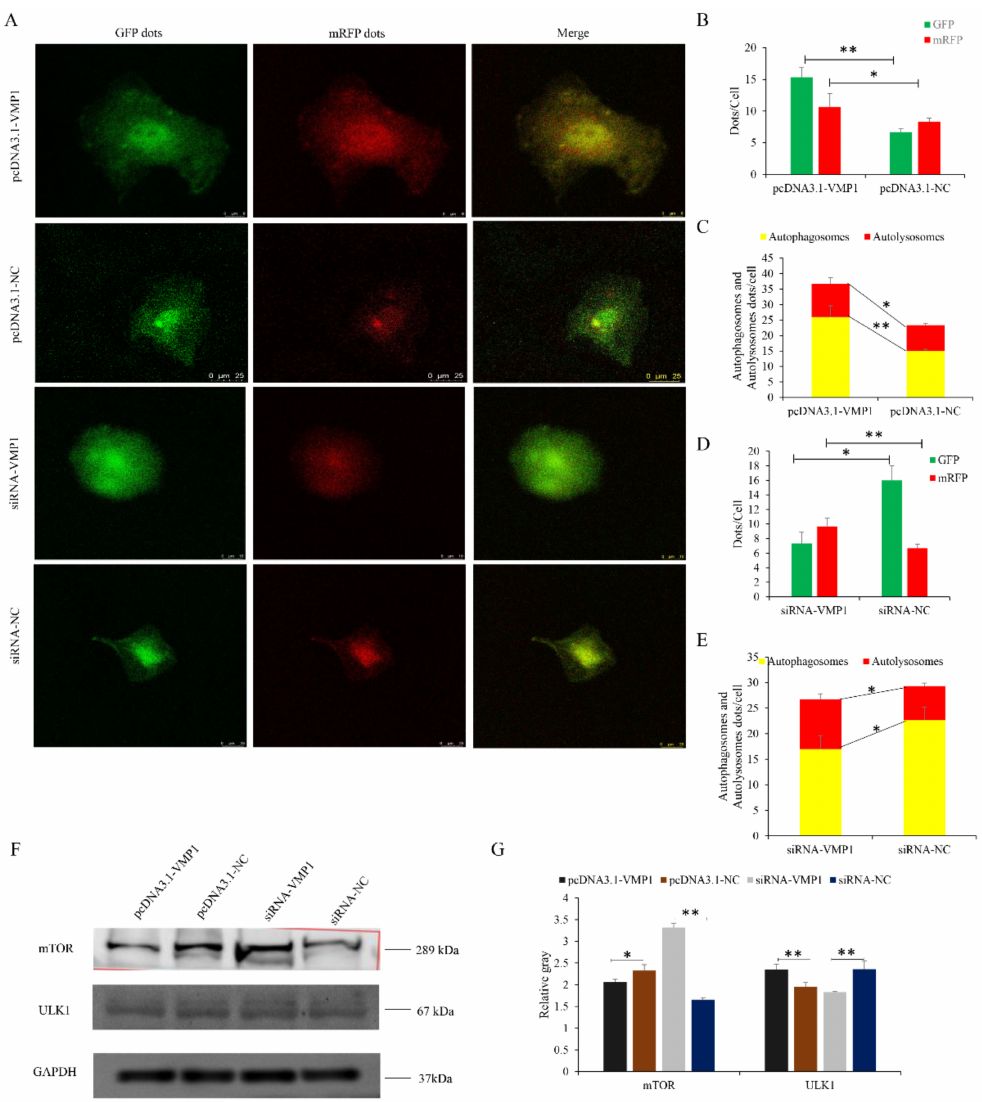
Figure 10. miR-124a regulates myoblast autophagy via the transient receptor potential of the VMP1/ULK1 pathway: ( A ) An adenovirus harboring tandem fluorescent mRFP-GFP-LC3 was used to evaluate the extent of autophagic flux after overexpression or inhibition of miR-124a. ( B , D ) Mean numbers of GFP and mRFP puncta per cell; three cells were randomly selected from each field to be counted. ( C , E ) Mean numbers of autophagosomes and autolysosomes per cell. Autophagosomes have green and red puncta, while in the merged images the puncta appear yellow. Autolysosomes have red puncta only. ( F , G ) Protein levels of ULK1/mTOR were detected after overexpression or inhibition of miR-124a. GAPDH was used as an internal standard. Replicates = 3. Data are presented as the mean ± SE; * p < 0.05 and ** p <